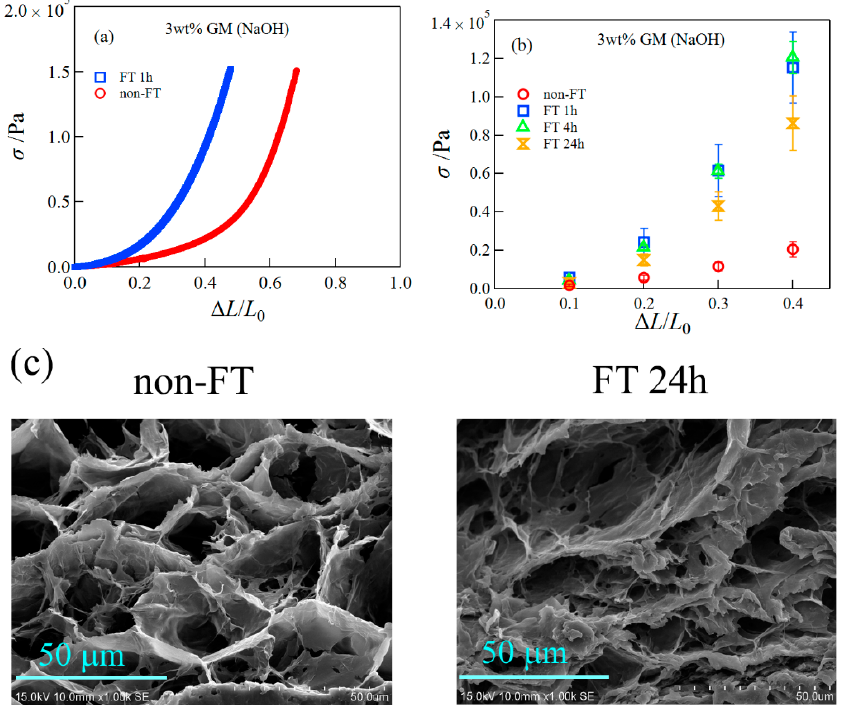
Figure 4. Representative compression stress–strain curves ( a ), the compressive stress at different strains ( b ), and SEM images of the cross-section of GM gels with and without FT treatment ( c ).